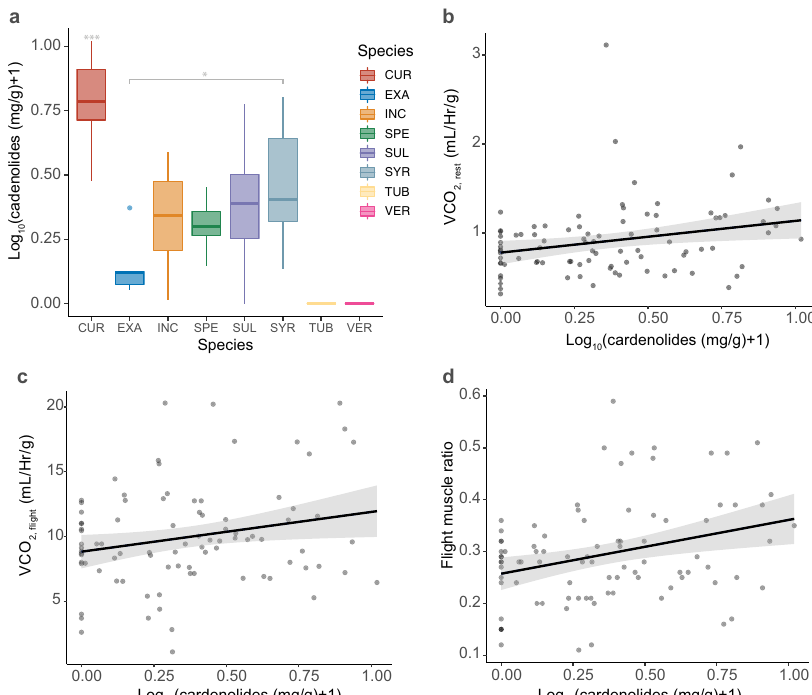
Fig. 3 Interactions with cardenolides on sequestration, respiration and musculature. a Wing cardenolide content (mg/g) of adult monarchs by host plant; wing samples of individuals reared on TUB and VER did not contain cardenolides. Each box represents one milkweed species. CUR, A. curassavica; EXA, A. exaltata; HIR, A. hirtella; INC, A. incarnata; LAE, C. laeve; SPE, A. speciosa; SUL, A. sullivantii; SYR, A. syriaca; TUB, A. tuberosa; VER, A. verticillata; top horizontal bar in box represents third quartile, followed by median and fi rst quartile; whiskers indicate data range. b Correlation of VCO 2 Rest (mL/Hr/ g) and adult wing cardenolide content (r 2 = 0.064, F(1,86) = 5.84, P = 0.0178). c Correlation of VCO 2 (mL/Hr/g) and adult wing cardenolide content (r 2 = 0.050, F(1,86) = 4.56, P = 0.0357). Cardenolide values were log transformed prior to analysis. d Correlation of Flight muscle ratio and adult wing